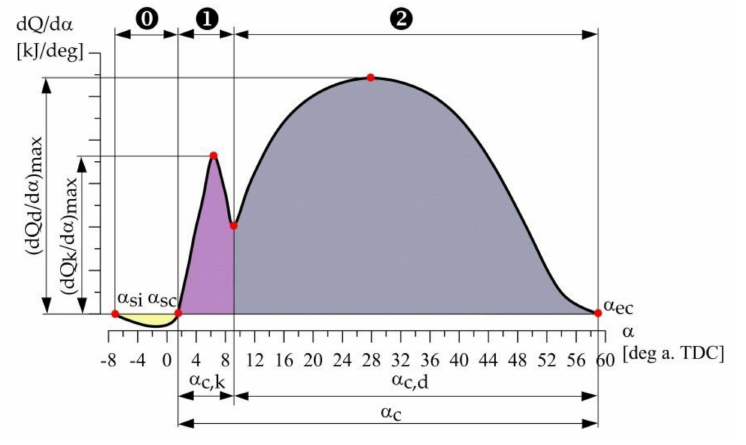
Figure 22. Heat release rate in the cylinder of the diesel engine. —fuel vaporization phase, —kinetic combustion phase, —diffusion combustion